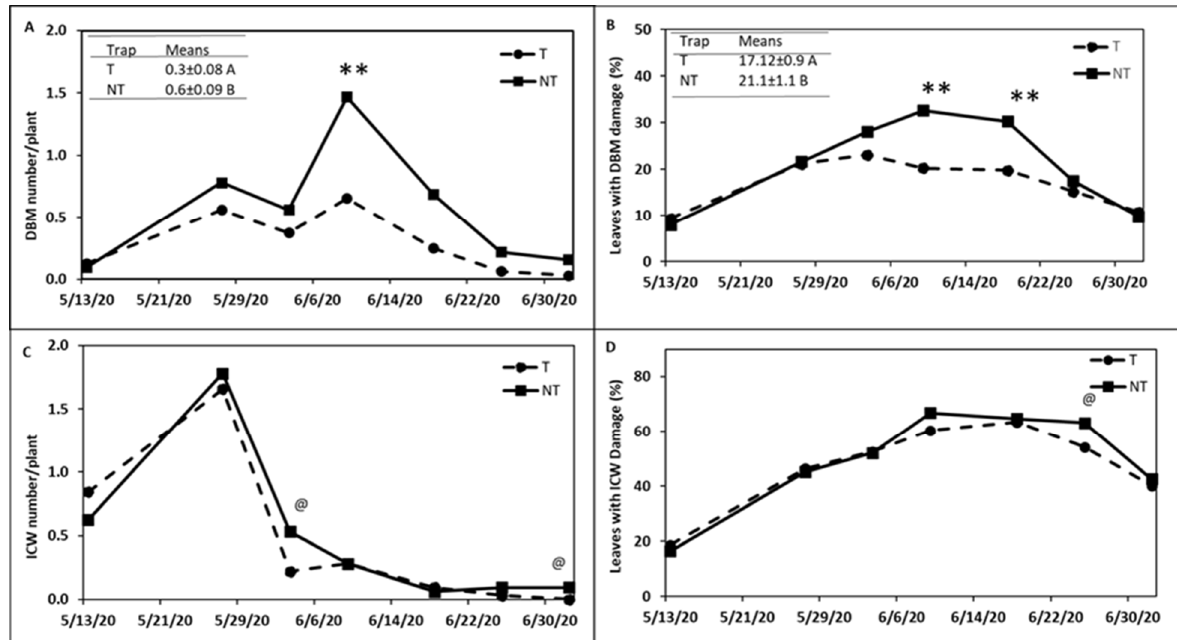
Figure 11. Effects of kai choi as a trap crop on ( A ) Abundance of diamondback moth (DBM); ( B ) Percentage of leaves with DBM damage; ( C ) Abundance of imported cabbageworm (ICW); ( D ) Percentage of leaves with ICW damage in Kale Trial I. ** indicate significant difference between trap crop (T) and no trap crop (NT) at p ≤ 0.05 and 0.01, respectively. @ indicates differences between EPN+ and EPN − at p ≤ 0.10 level. Means followed by the same letters are not different based on analysis of variance. Horticulturae 2022 , 8 , x FOR PEER REVIEW